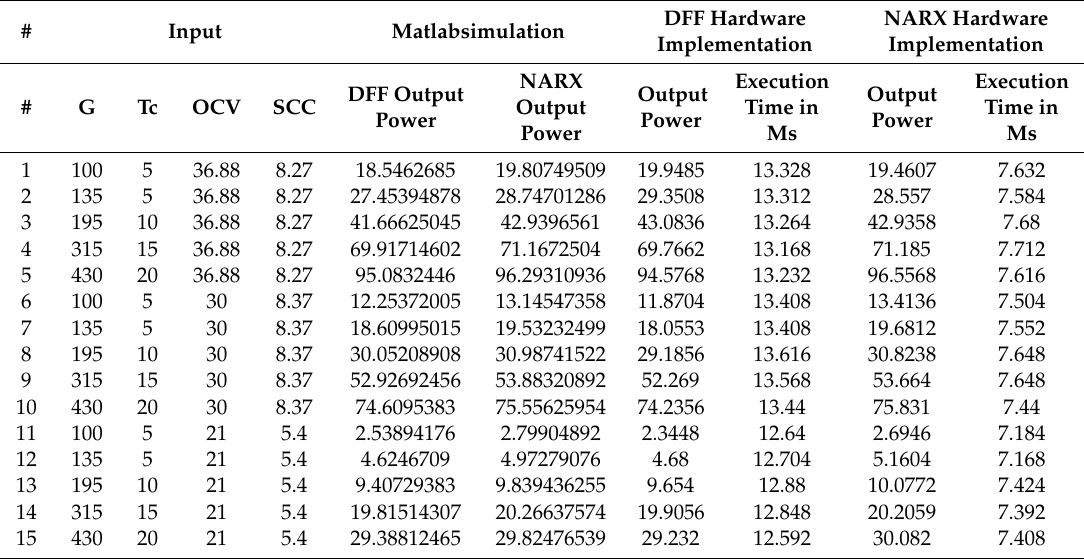
Table 6. Execution time and accuracy results from DFF and NARX networks hardware implementations on low cost